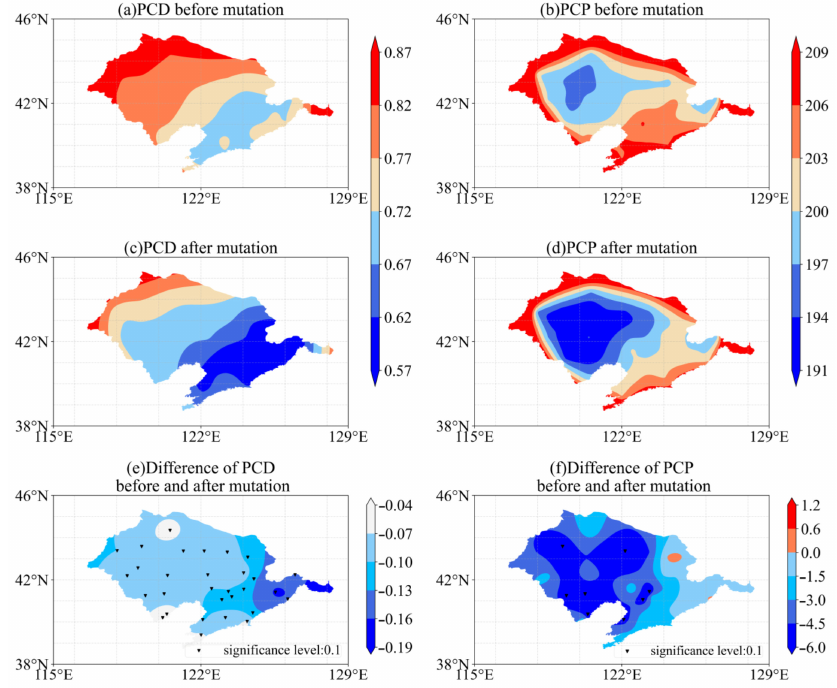
Figure 3. Spatial distribution maps of PCD&PCP: Spatial distribution of ( a ) PCD and ( b ) PCP before mutation year; spatial distribution of ( c ) PCD and ( d ) PCP after mutation year; differences before and after the mutation of ( e ) PCD and ( f )